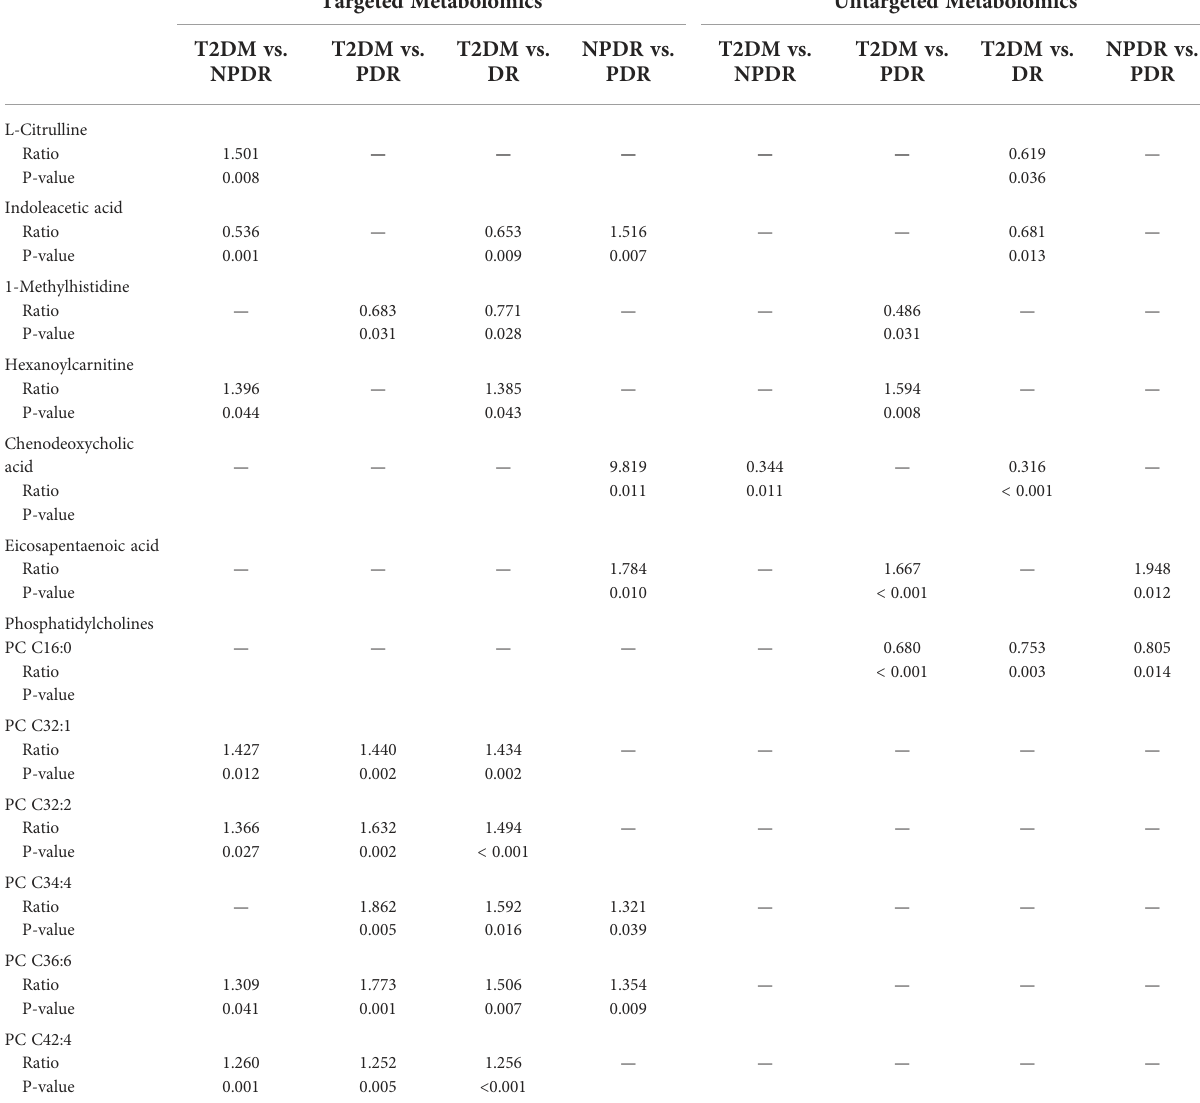
TABLE 2 Metabolites of DR critical period identi fi ed from targeted and untargeted metabolomic pro fi ling (13)